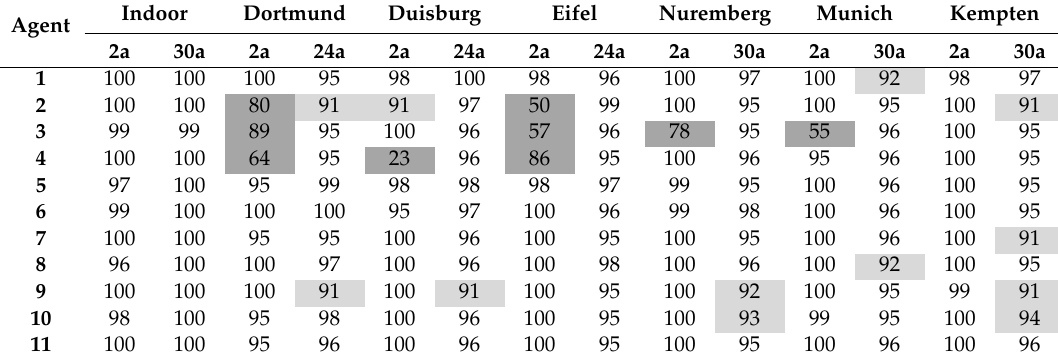
Table 5. Protection degree PD LP calculated from water absorption by pipe method after a weathering time of 2, 24 and 30 years, respectively, at the 7 locations (PD classes: 100% to 95%: hydrophobic (white